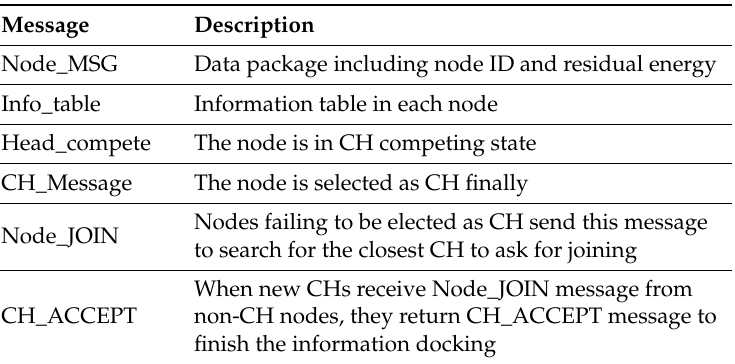
Table 1. Messages